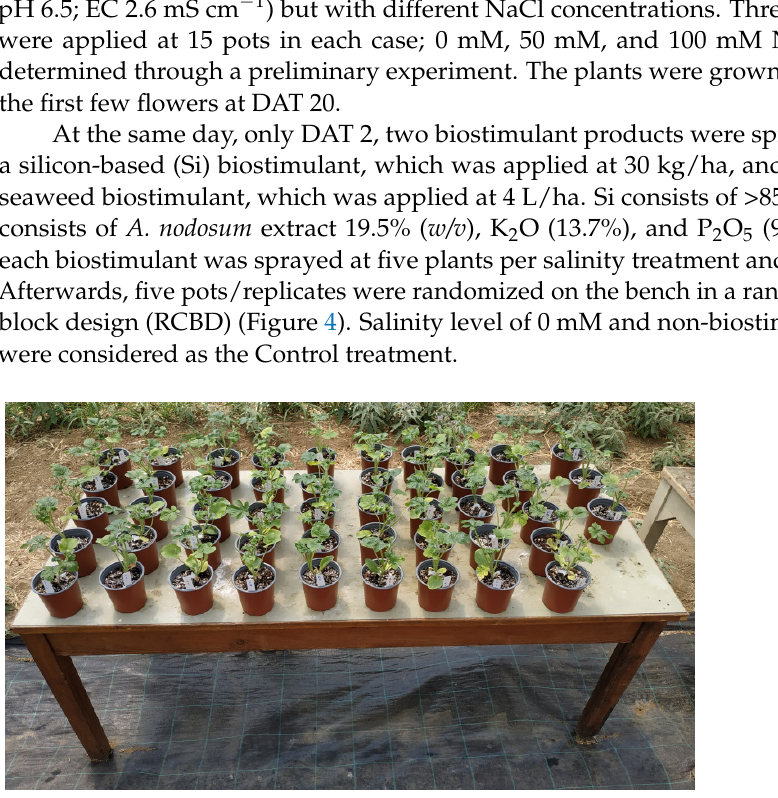
Figure 4. Watermelon seedlings transplanted in pots, irrigated with nutrient solution of different NaCl concentration, and sprayed with two